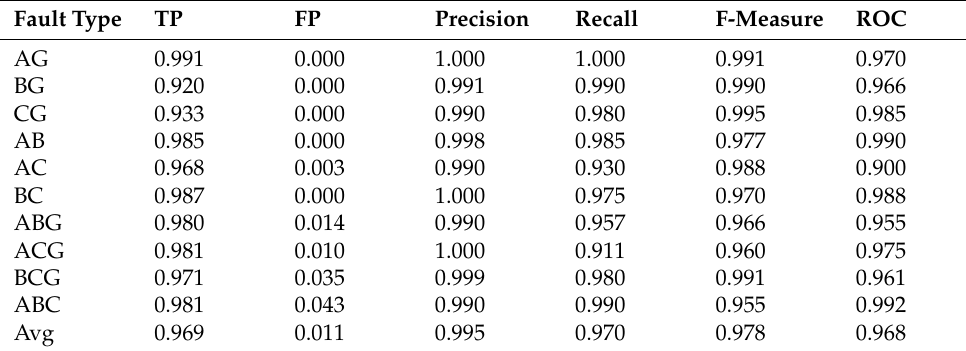
Table 6. SVM classification with half a cycle post-fault.